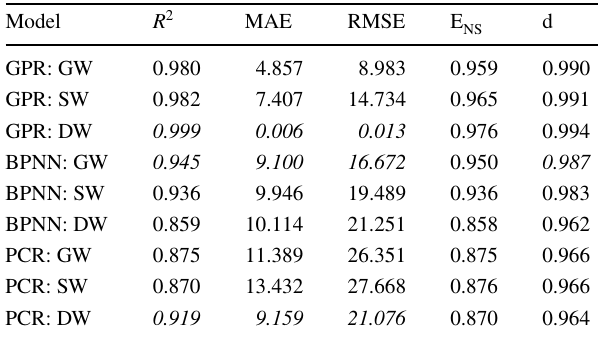
Table 5 Comparison of models’ performance for GW, SW and DW Model